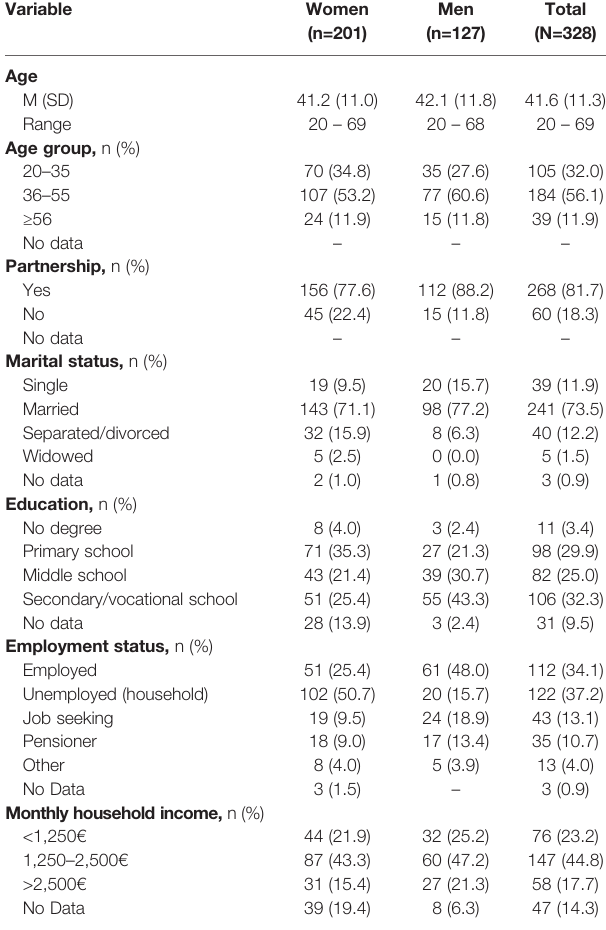
TABLE 1 | Socio-demographic characteristics of female and male migrants of Turkish origin and the total sample.